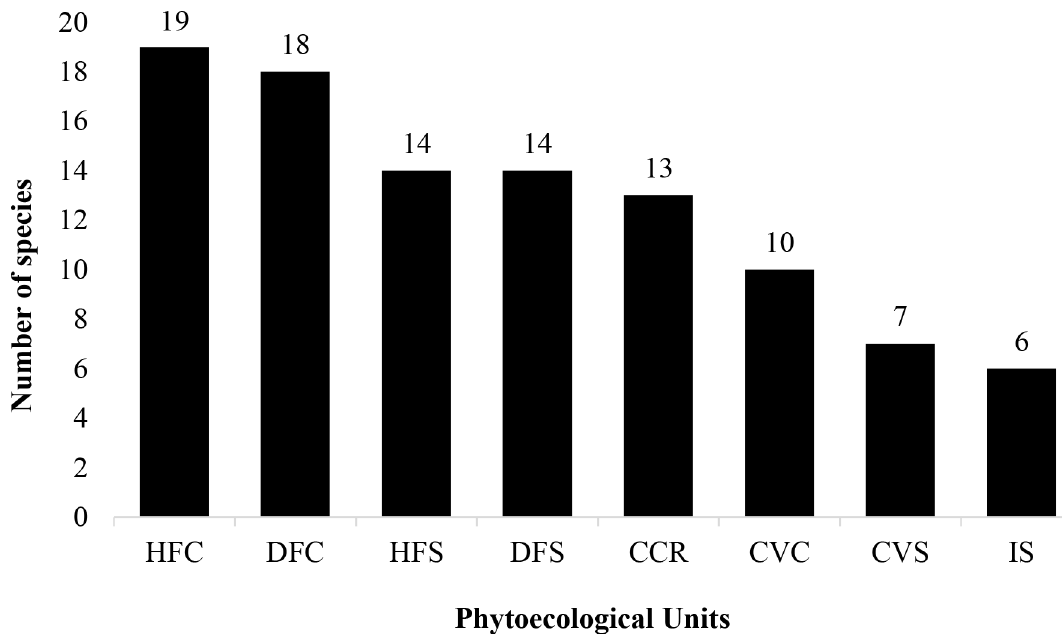
Figure 2. Representation of the number of meliponine species in eight phytoecological unit of the State of Ceará in 2013 and 2014. Phytoecological Units: HFC - Humid forest of the Crystalline Landscapes; DFC - Dry Forest of the Crystalline Landscapes; HFS - Humid Forest of the Sedimentary Landscapes; DFS- Dry Forest of the Sedimentary Landscapes; CCR- Caatinga Vegetation on Crystalline Relief; CVC - Coastal Vegetation Complex; CVS - Caatinga Vegetation on Sedimentary Relief; IS – Inland